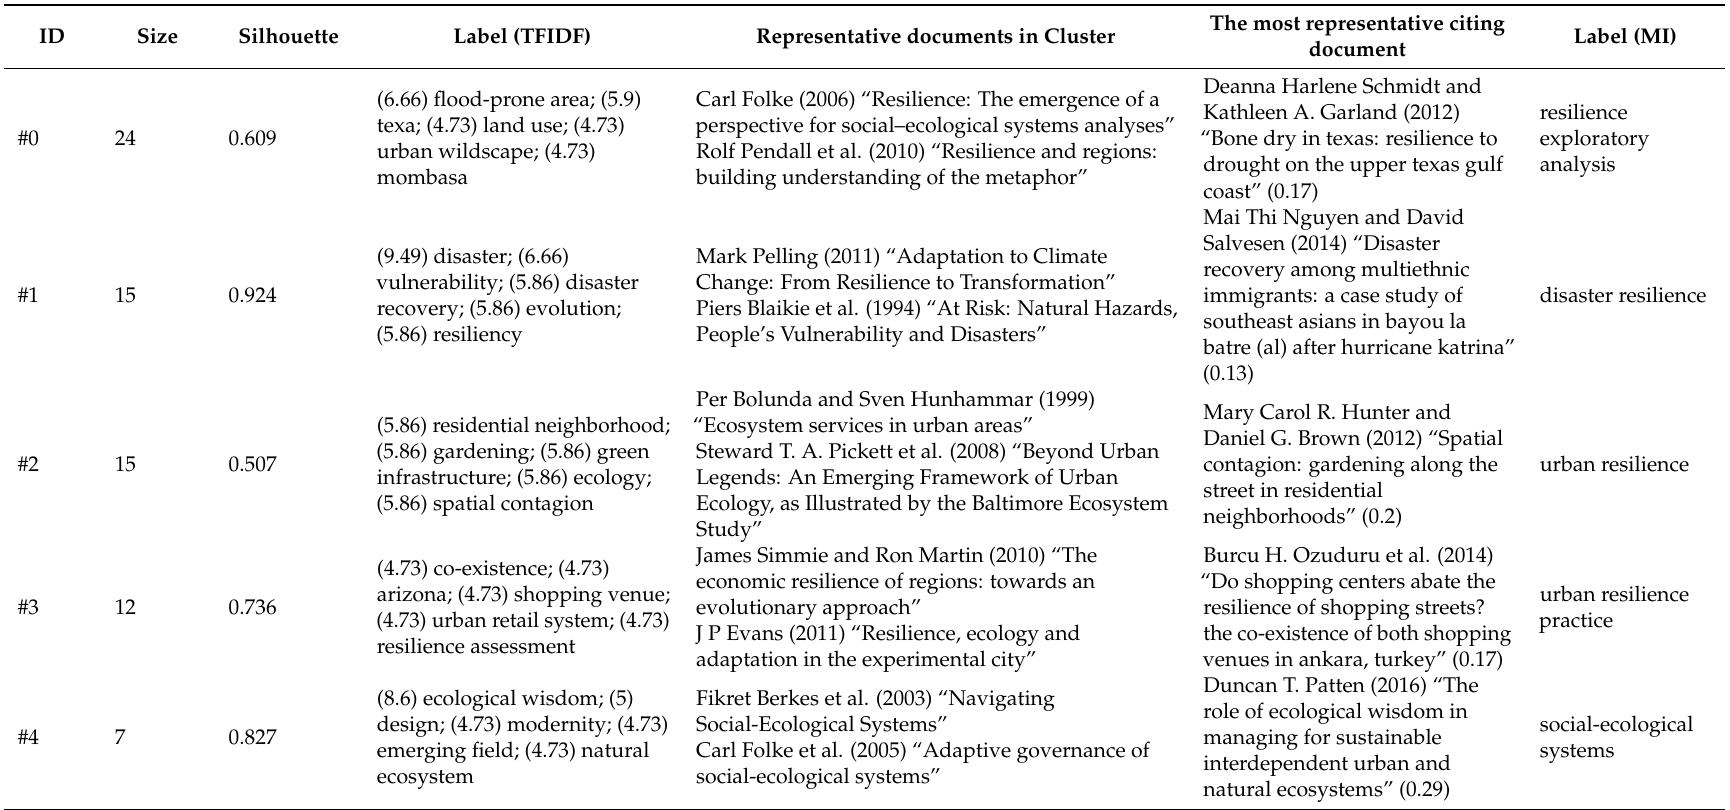
Table 7. The 5 clusters’ contents in document co-citation